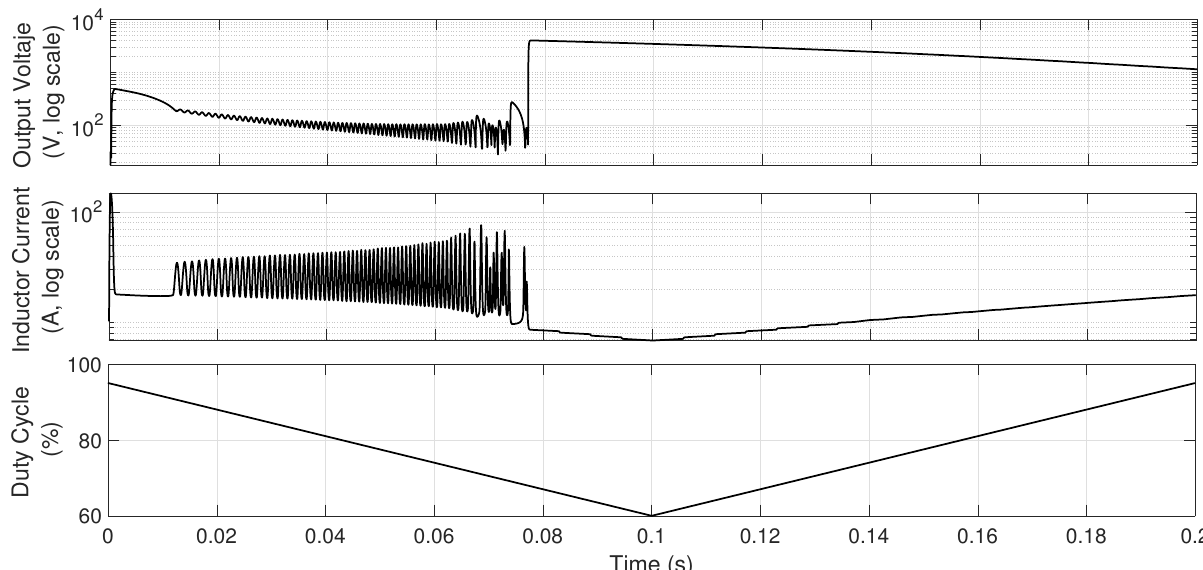
Figure 11. Illustration of open-loop, unstable behavior dependence on u 1 . For this example, the same previous parameters are used with P = 500 W. Average output voltage and inductor current are obtained by PSIM (averaged values) and shown in logarithmic scales. u 1 is introduced as a (slow-dynamics) triangular wave to show how values lower than approximately 72% destabilizes the converter with a CPL; even worse, even if the active cycle increases again, stability cannot be recovered. Note that for high values of u 1 , the voltage and current do not show large amplitude oscillations, but as the cycle decreases, the oscillations increase